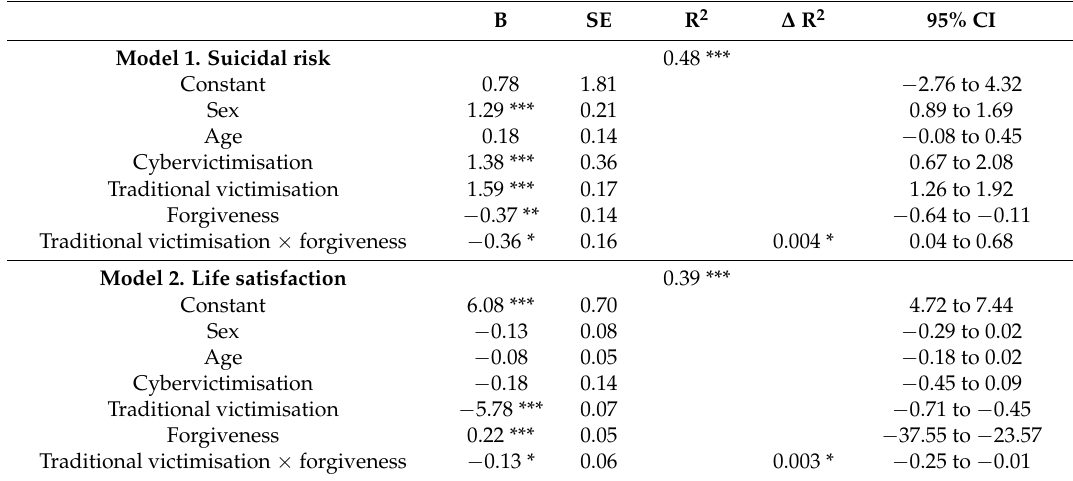
Table 2. Tested moderation models with suicidal risk and life satisfaction as outcomes predicted by traditional victimisation, forgiveness and multiplicative interaction